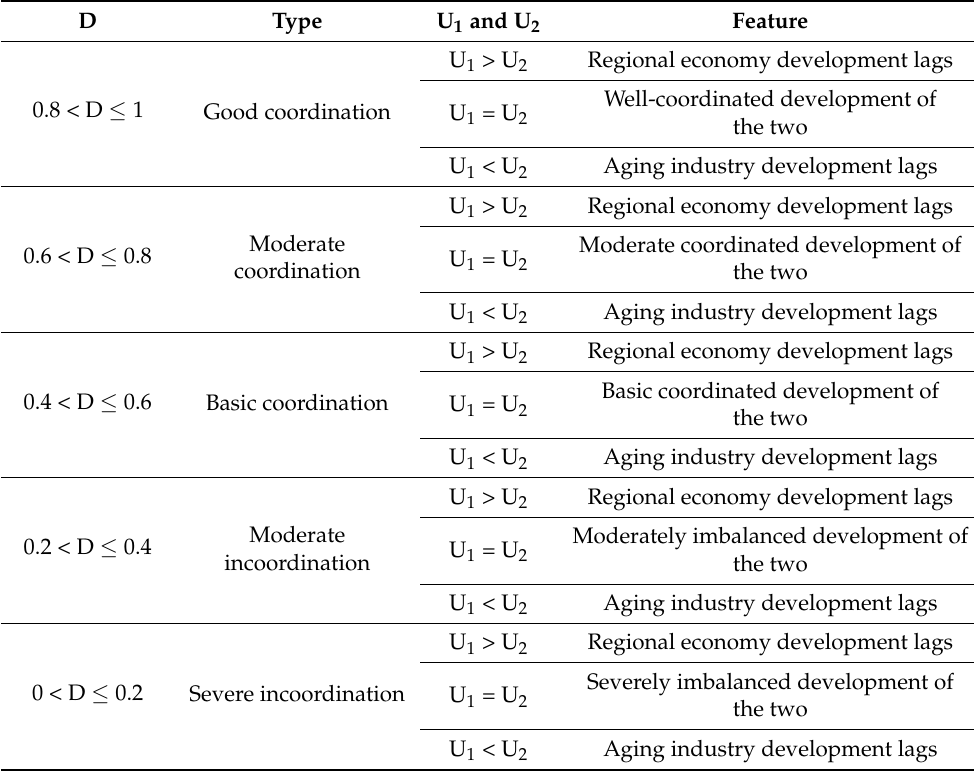
Table 2. Classification standard of coupling coordination degree between the aging industry and regional economy